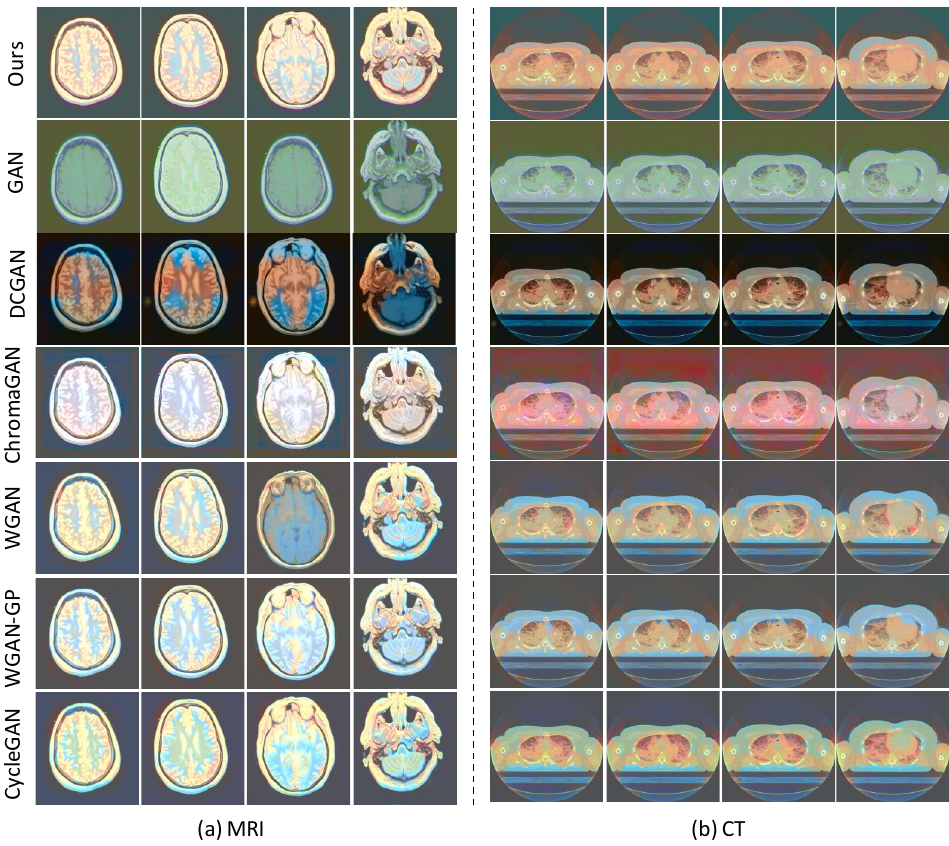
Figure 3. Qualitative colorization results of MRI images and CT images of the VHP dataset using different GAN-based image colorization